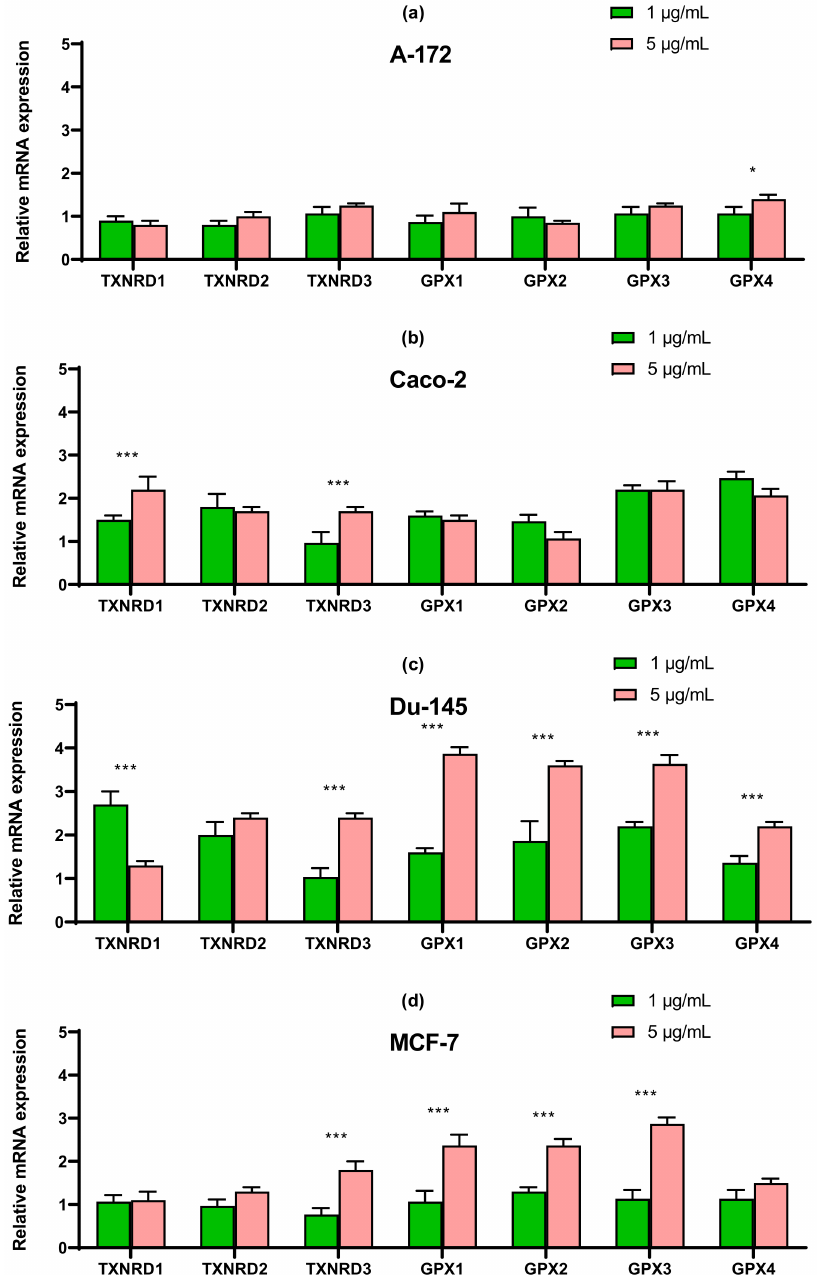
Figure 9. qRT-PCR analysis of the expression of selenium-containing glutathione peroxidase and thioredoxin reductase gene (1 and 5 µ g/mL SeNP, 24 h)-treated cancer cells ( a )—A-172; ( b )—Caco-2; ( c )—Du-145; ( d )—MCF-7. Each value is the mean ± SD of at least three independent experiments ( n ≥ 3, p < 0.05). GAPDH was used as an internal control for normalization. Two-way ANOVA with Sidak’s multiple comparisons test. Comparison 1 µ g/mL and 5 µ g/mL, *** p -level < 0.001, * p -level <